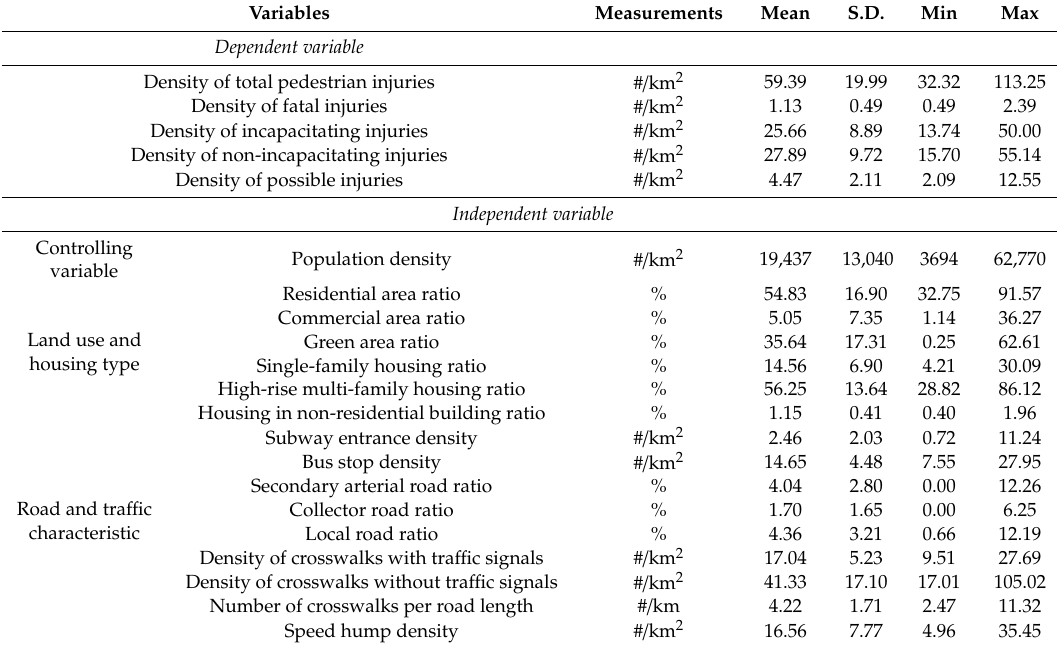
Table 3. Descriptive statistics of